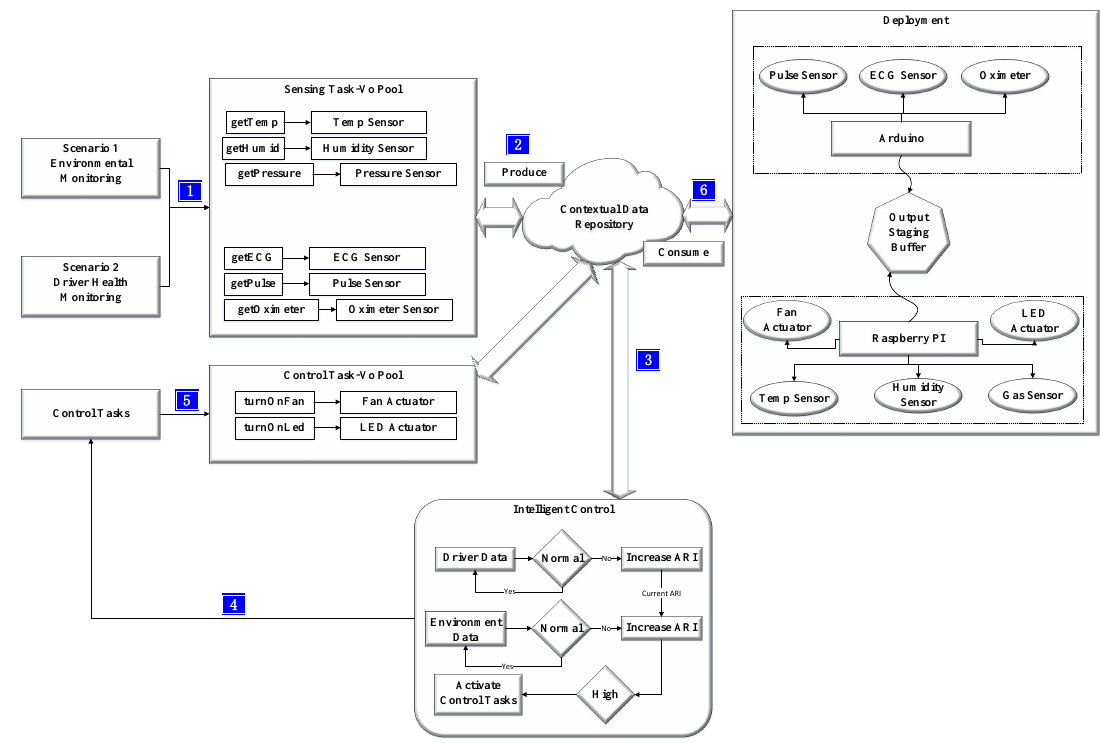
Figure 3. Control scheduling flow based on risk index profile in a driver-assistance